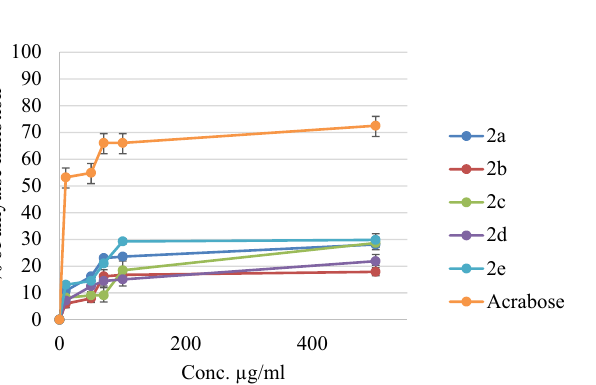
Figure 4. The Inhibition % of lipase that induced by compounds ( 2a-2e ) and the positive control (Orlistat).